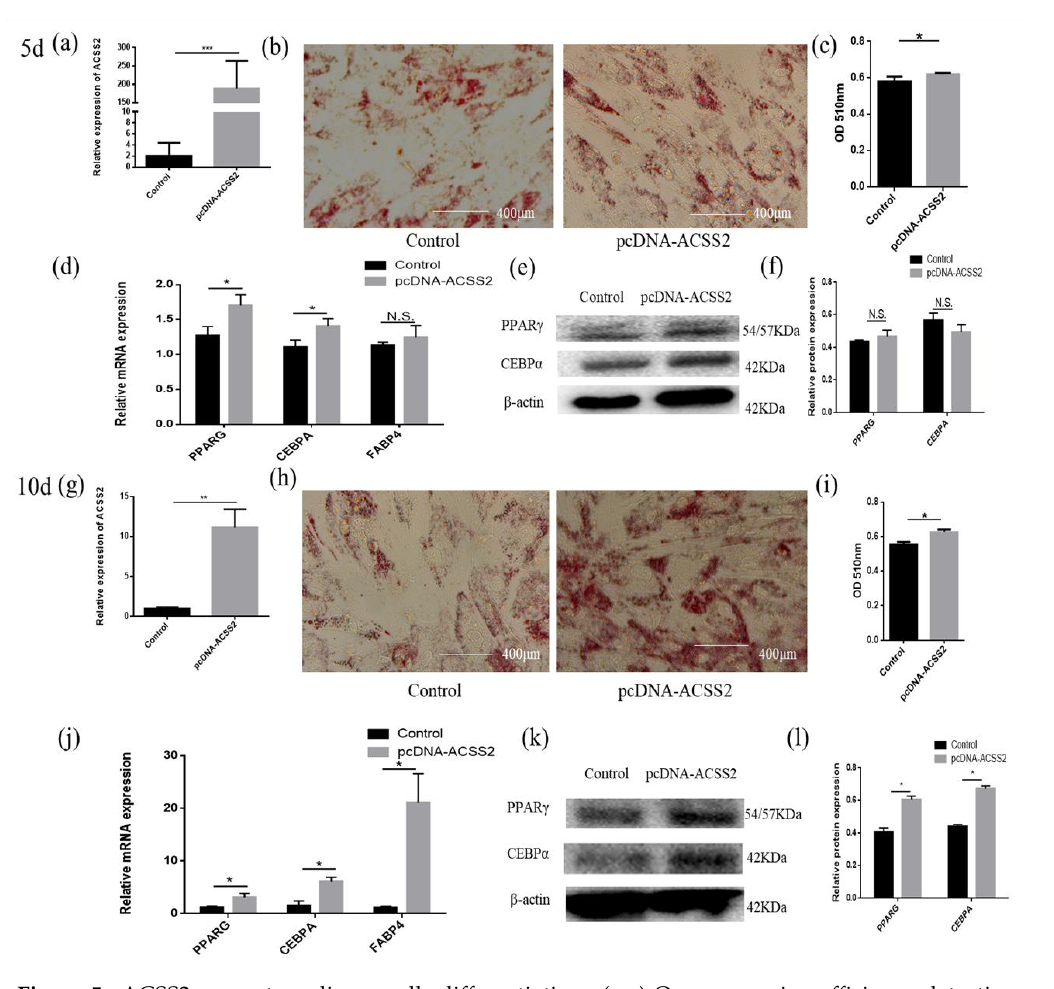
Figure 5. ACSS2 promotes adipose cells di ff erentiation. ( a , g ) Overexpression e ffi ciency detection at day 5 d or 10 d. ( b , h ) Oil Red O staining of adipose cells with bta-miR-193b at day 5 d or 10 d. ( c , i ) The results quantified by microplate reader at 510 nm. ( d – f , j – l ) Overexpression of ACSS2 in adipose cells and continues induced to undergo di ff erentiation for 5 or 10 days, and subsequent detection the mRNA expression of PPARG, C / EBPA and FABP4 by RT-qPCR compared with control group, and di ff erentiation of adipose cells detected by Western blot. The expression of miRNAs was normalized to U6. Values are mean ± SD for three biological replicates, * p < 0.05, ** p < 0.01, *** p < 0.001; N.S. represent